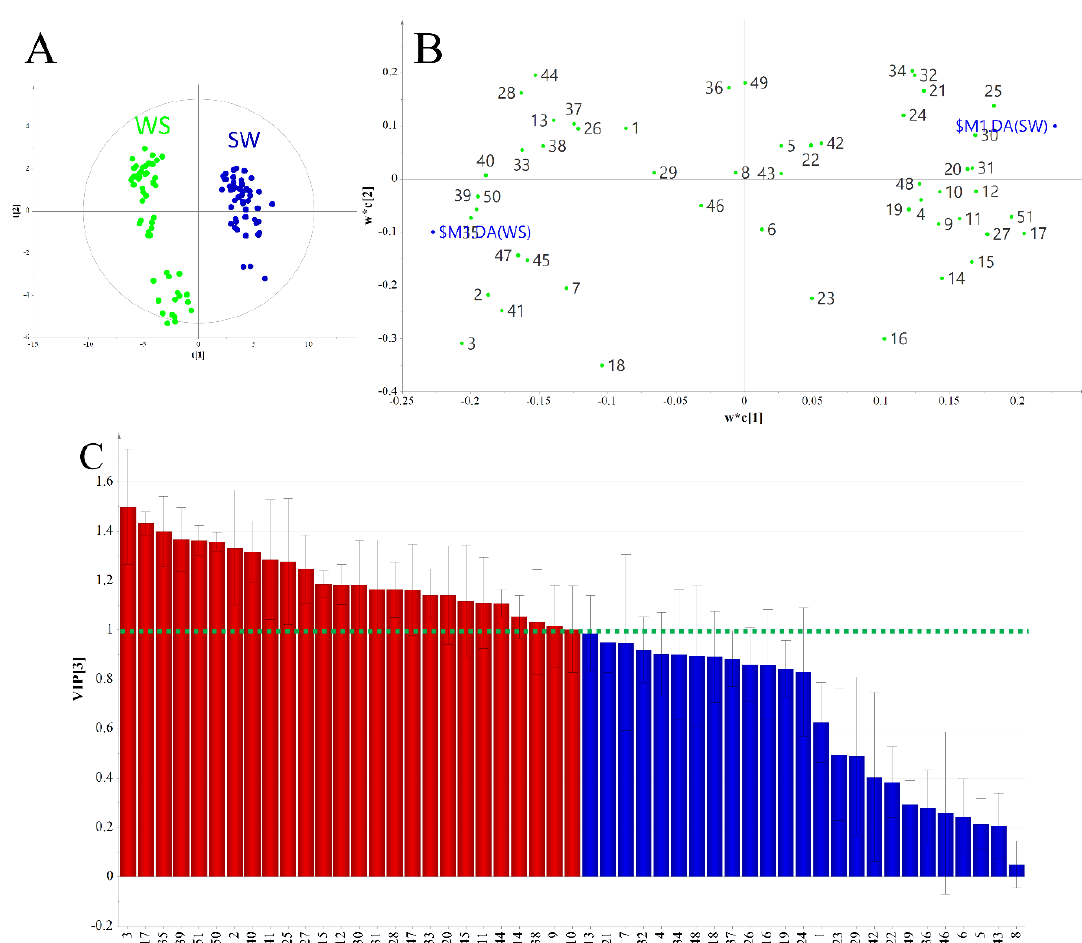
Figure 3. ( A ) Partial least squares discriminant analysis (PLS − DA) scores plot, ( B ) loading plot, and ( C ) variable importance prediction (VIP) plot of volatile compounds in black teas processed by withering-shaking and shaking-withering. ( B , C ): The numbers on the abscissa represent compounds, and the corresponding relationship between numbers and compounds is shown in Table S1 of the Supplementary